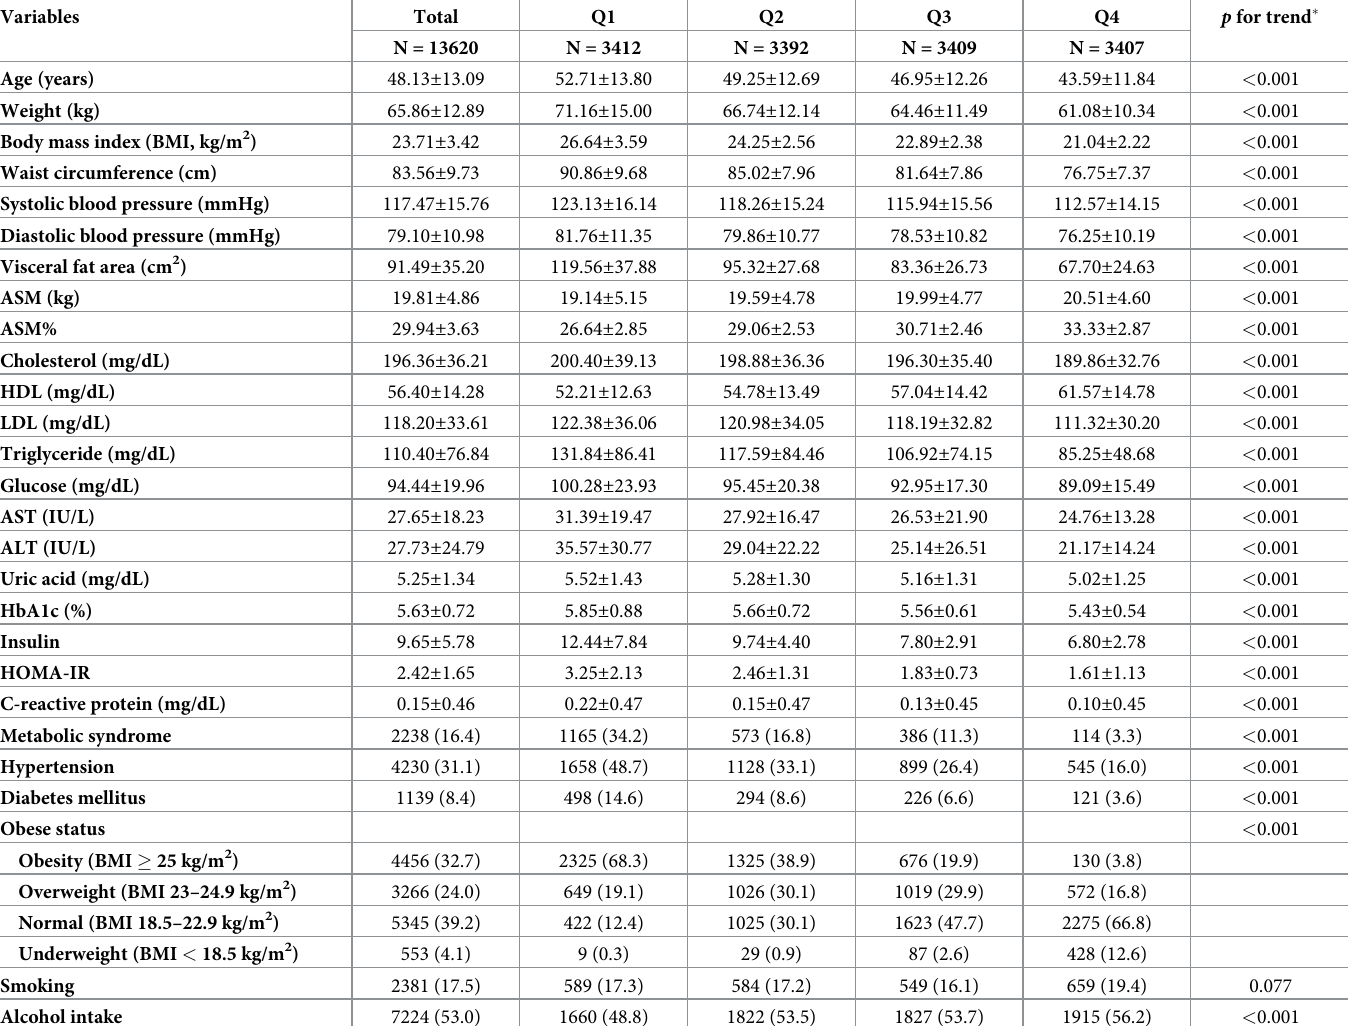
Table 1. Clinical characteristics according to ASM%